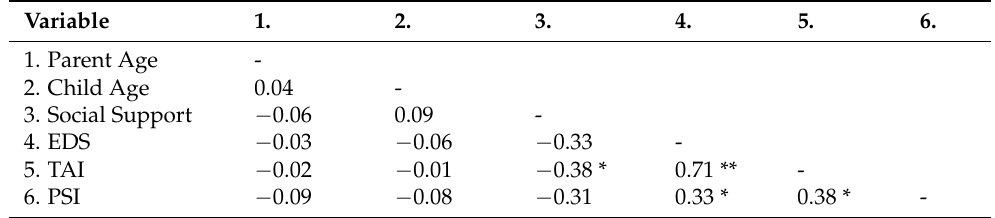
Table 2. Correlations between variables.